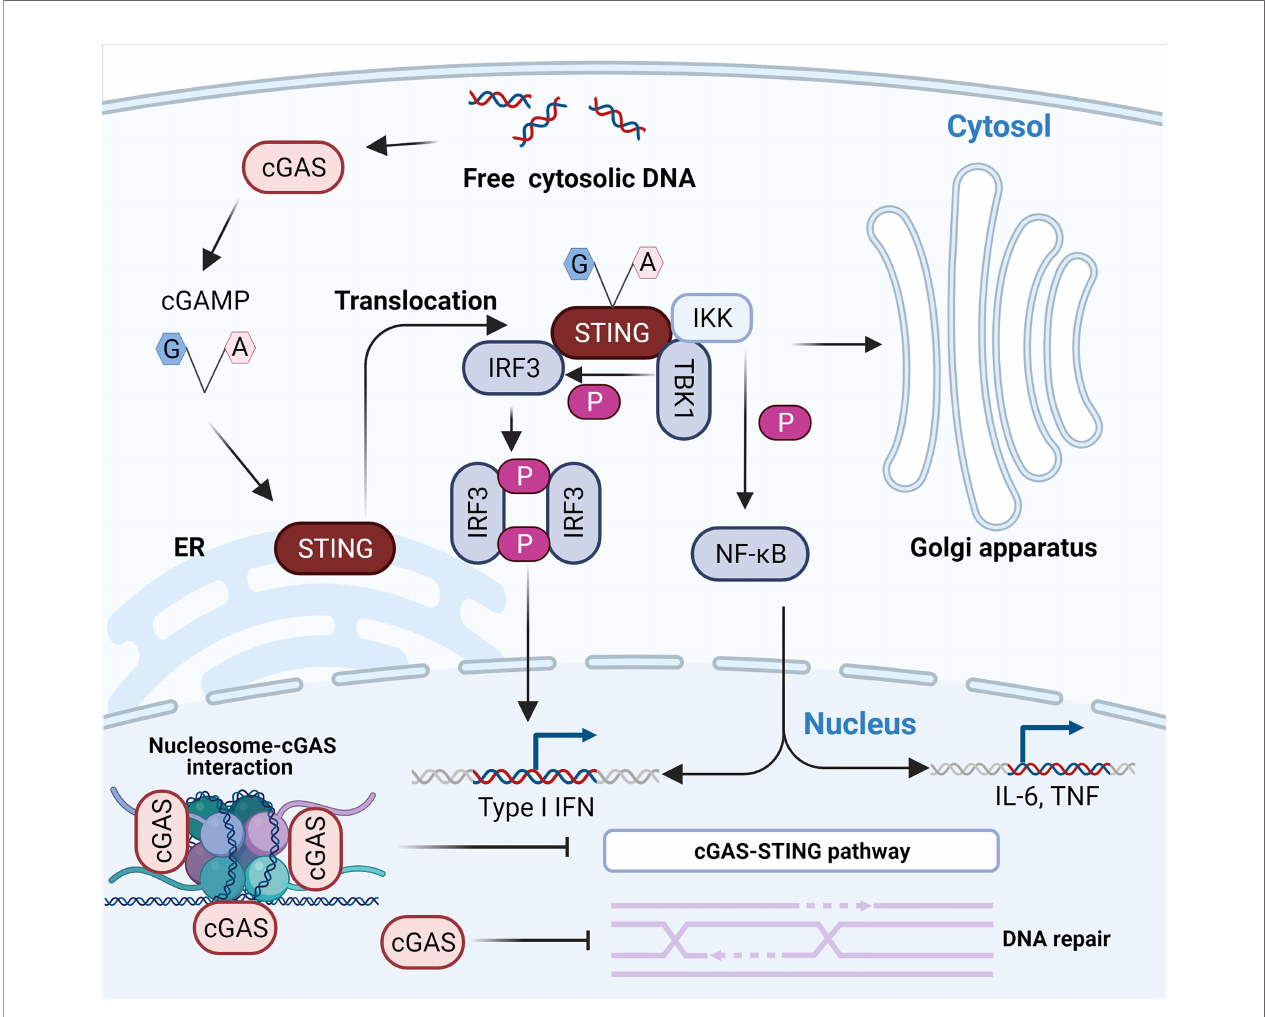
FIGURE 1 | The cytosolic DNA-activated cGAS-STING pathway. The recognition of free dsDNA in the cytoplasm by cGAS activates the production of 2 ’ -3 ’ -cGAMP, a natural ligand of ER-resident STING. The binding of 2 ’ -3 ’ -cGAMP to STING results in its translocation to the ER-Golgi intermediate compartment (ERGIC) and the Golgi apparatus. The relocated STING activates TBK1 and IKK. First, activated TBK1 phosphorylates STING, which consequently recruits and phosphorylates IRF3. The phosphorylated activated IRF3 dimerizes and enters the nucleus to initiate transcription of type I IFN. In addition, activated IKK results in the activation and nuclear transport of NF- k B to induce the expression of type I IFN and in fl ammatory cytokines such as TNF and IL-6. The interaction between cGAS and nucleosomes prevents the activation of cGAS. Notably, nuclear cGAS suppresses homologous recombination and promotes